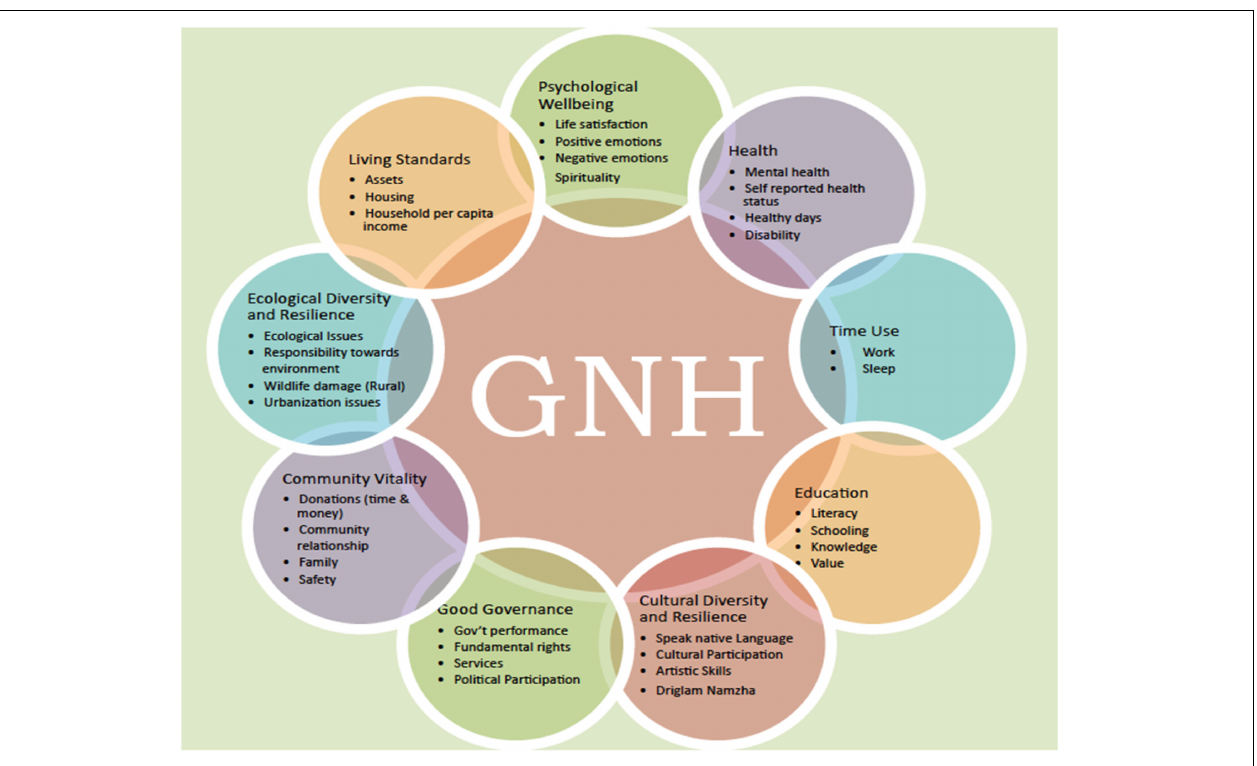
FIGURE 4 | Gross National Happiness (GNH) Index, applied in the kingdom of